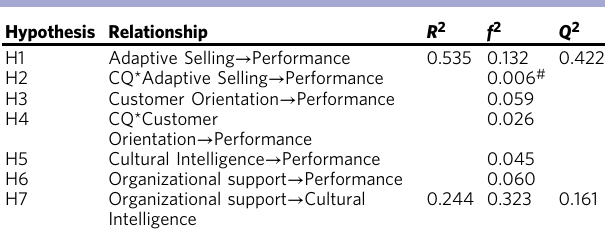
Table 7 Interpretation and prediction capacity veri fi cation